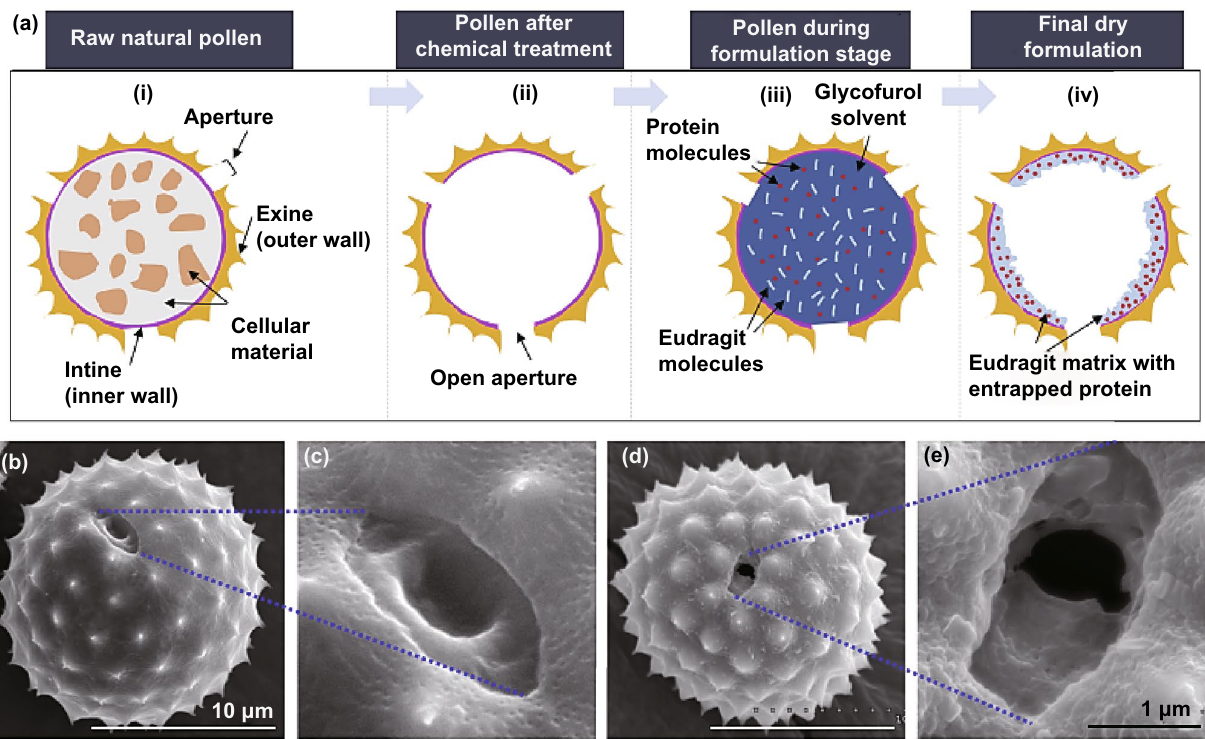
Fig. 2 a Pollen grains for oral delivery of proteins. Pollen grain-based formulation with scanning electron microscopy (SEM) of raw pollen grain with closed aperture ( b , c ), and processed pollen grain with open aperture ( d , e ). Reproduced with permission from Ref. [24]. (Color figure